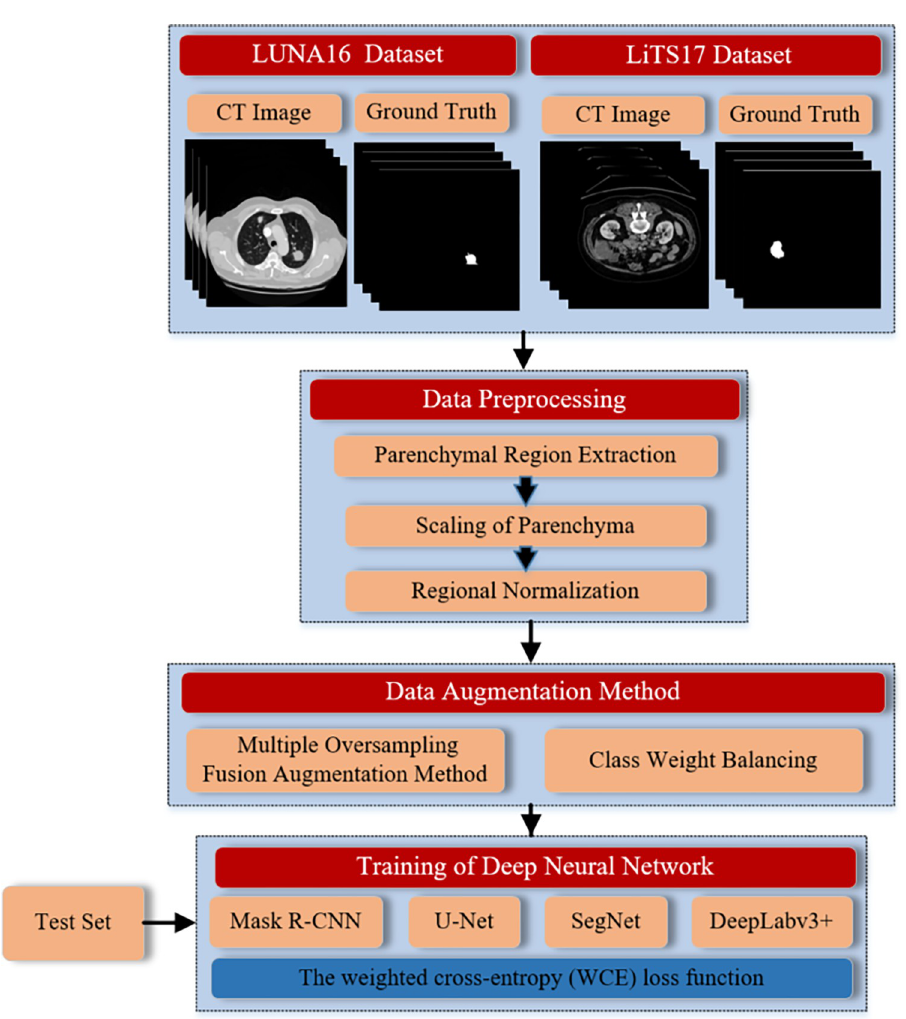
Fig 1. The framework of the proposed small tissue lesions segmentation